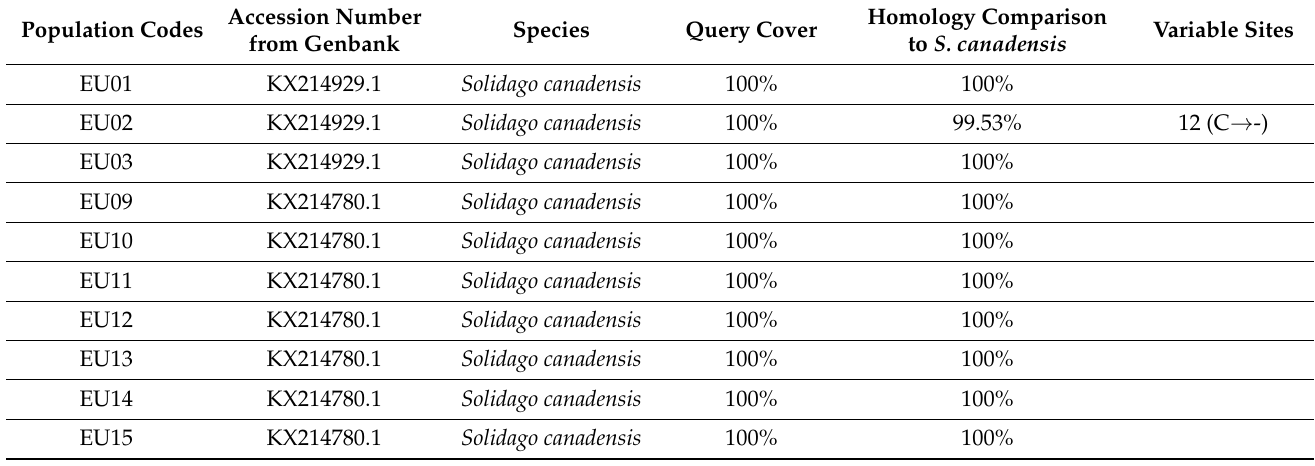
Table 2. Test of psb A- trn H intergenic spacer sequences of Solidago canadensis blasted in NCBI database.